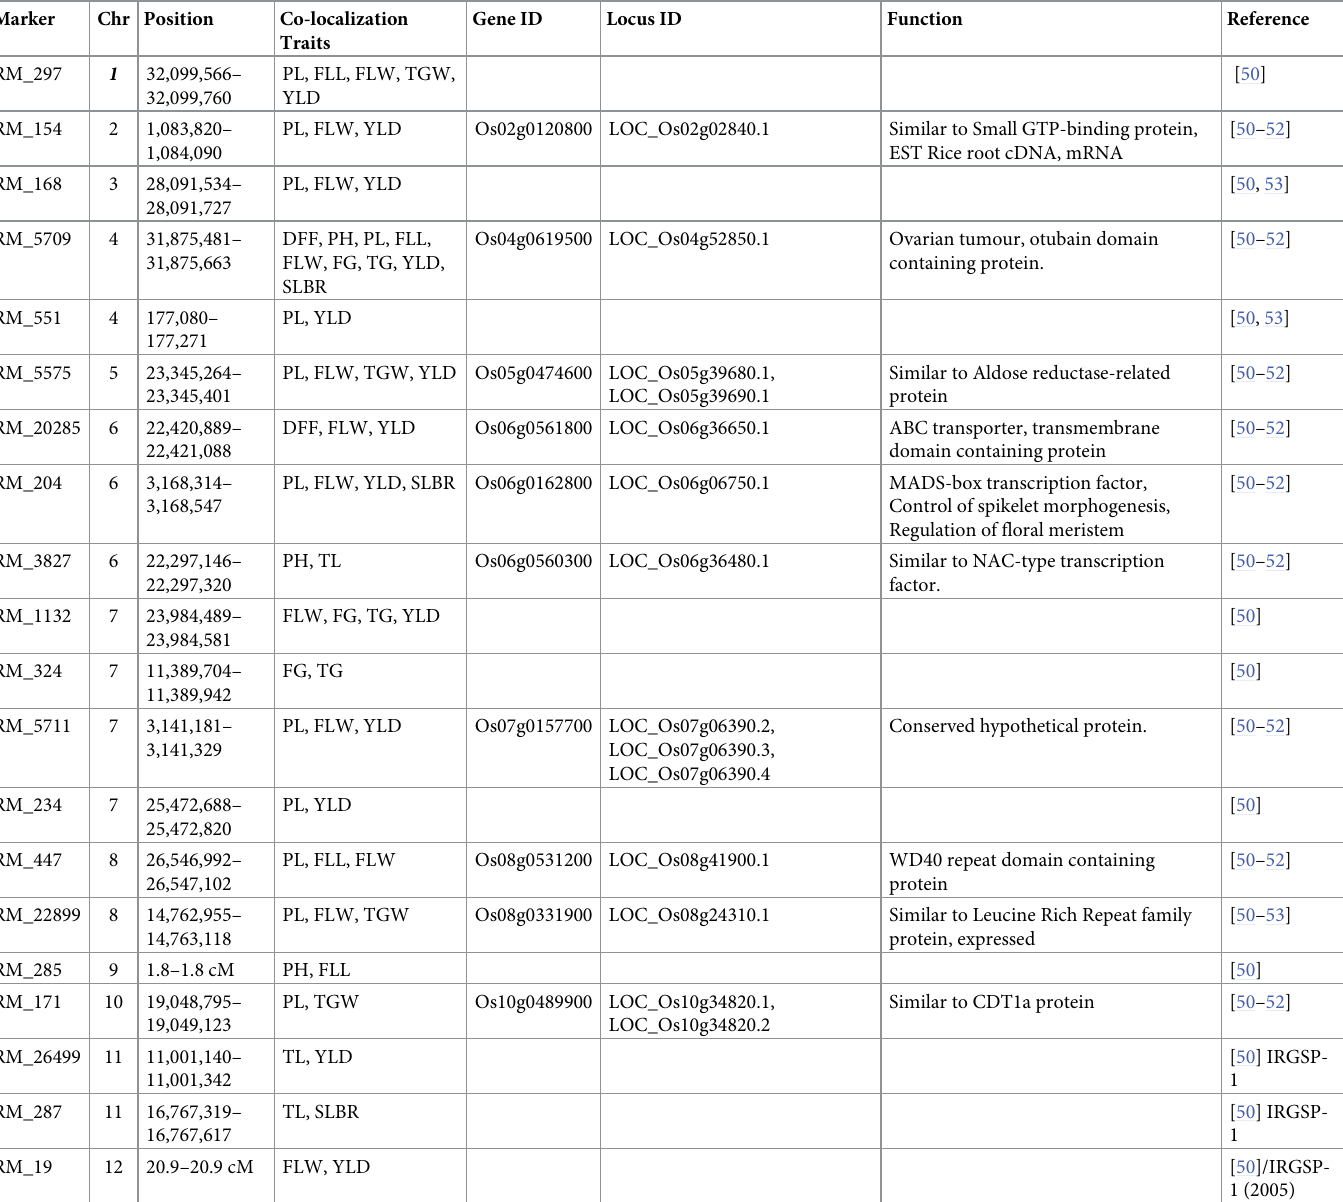
Table 6. Identification of SSR markers associated with more than one